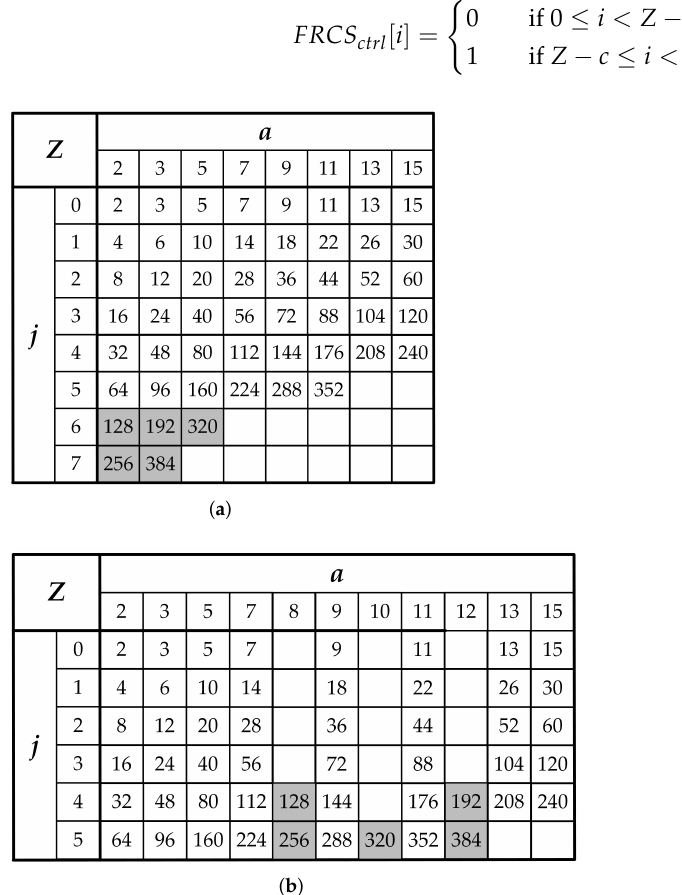
Figure 4. ( a ) Lifting size Z table; ( b ) Modified lifting size Z table for standard 5G LDPC